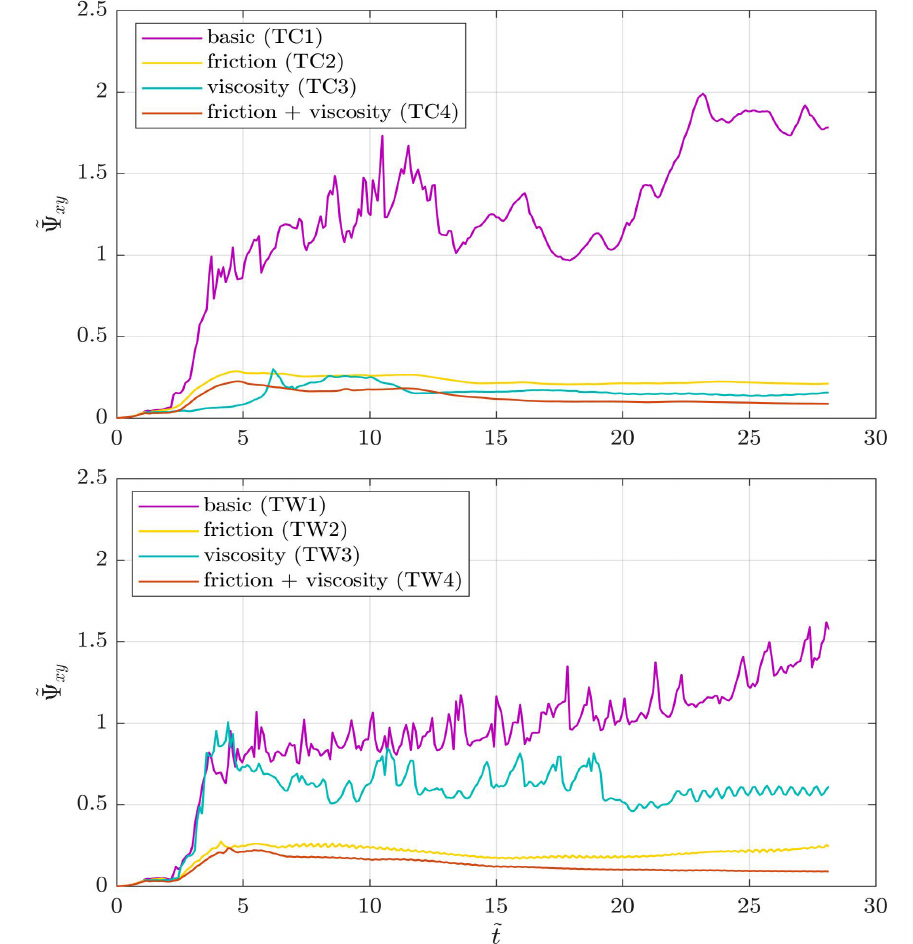
Figure 12. Time series of the dimensionless domain-integral OW parameter ˜ Ψ xy as a function of the dissipation mechanisms. Top : tests with river current only (TC1 to TC4). Bottom : tests with a monochromatic wave opposing the river current (TW1 to